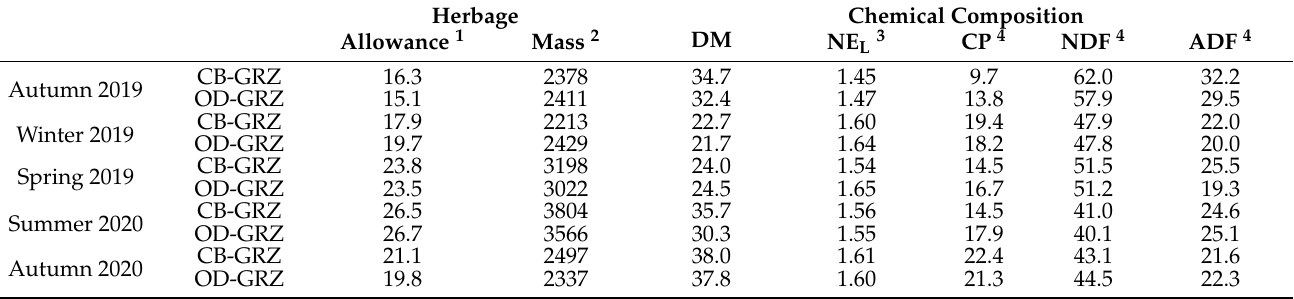
Table 2. Forage management and chemical composition in each season in mixed systems with low (CB-GRZ) or high (OD-GRZ) environmental